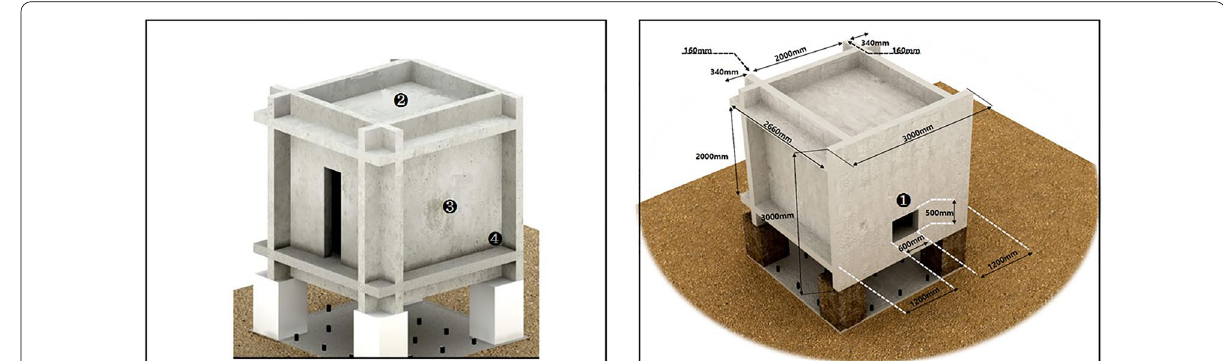
Fig. 3 Reflection pressure sensor locations.